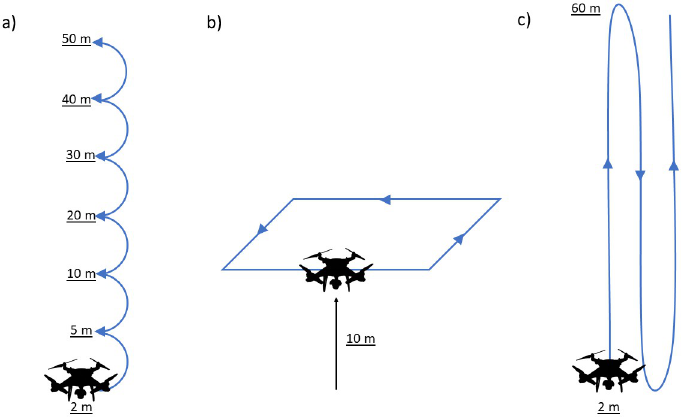
Fig 1. Schematic of the three field trials which used a UAS to assess the accuracy of altitude estimates of avian tracking devices. a) stationary flights performed by stopping for 30 seconds at 2, 5, 10, 20, 30, 40 and 50-meter heights; b) continuous horizontal movements where the UAS was kept at a consistent 10-meter height while moving around the perimeter of the study site (approximately 180m x 60m); c) vertical movements where the UAS made continuous ascensions/descensions from 2 to 60 meters but did not move in the horizontal